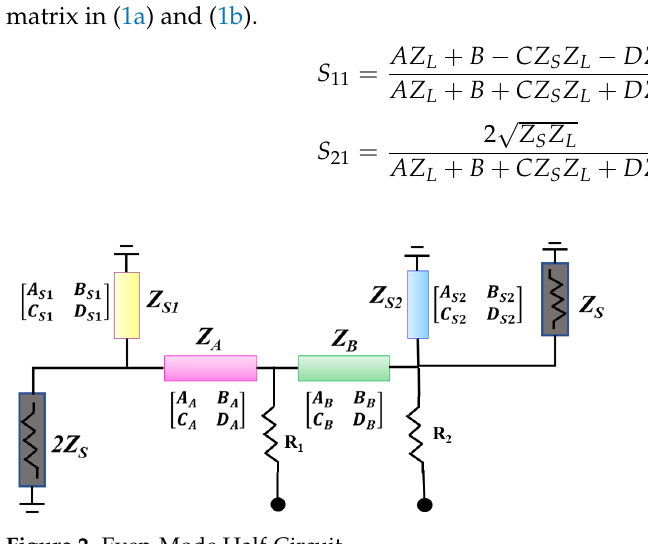
Figure 2. Even-Mode